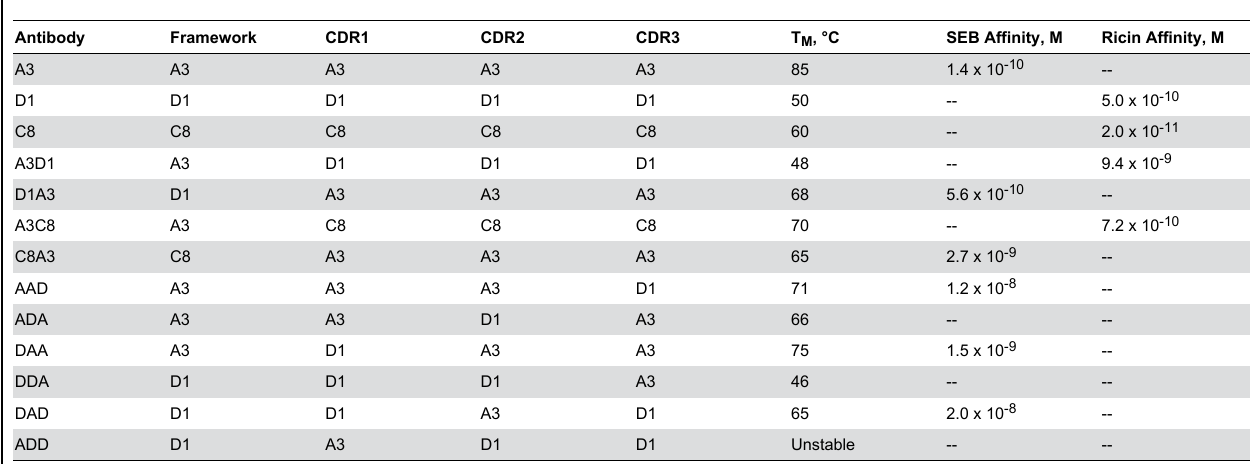
Table 1. Melting temperature and binding affinity.